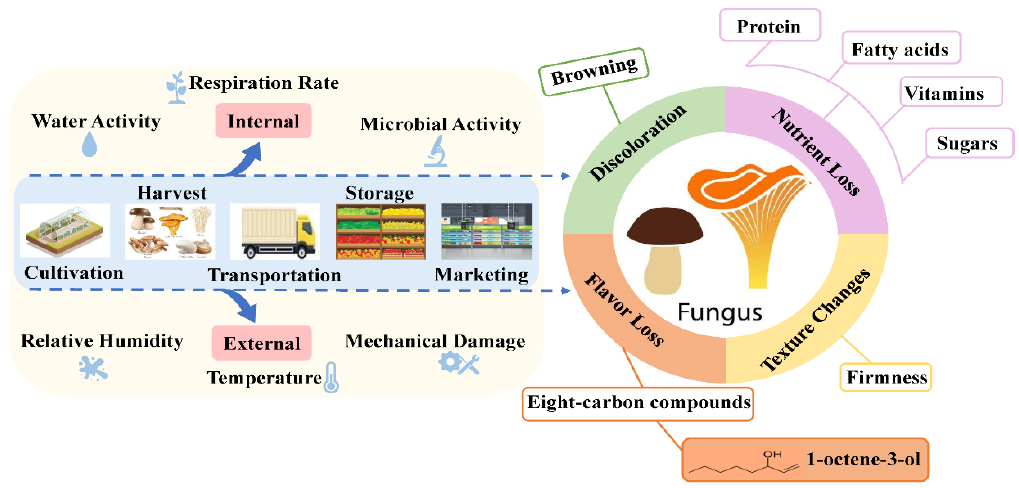
Figure 1. The relationship between postharvest quality degradation and influential factors.